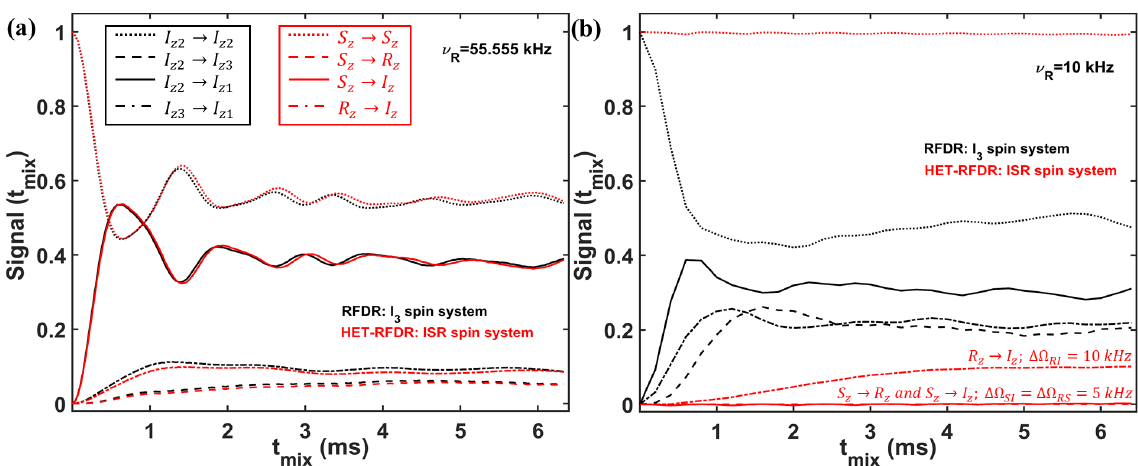
Figure 4. Comparison of the simulated RFDR and HET-RFDR signals. I 3 (three homonuclear spins, black lines) and ISR (three different spin types, red lines) for 55.555kHz (a) and 10kHz (b) MAS. An rf field of 83kHz is used (6µs of the widths of π pulses). The vertical axis shows the intensities of the starting and transferred signals between different operators of I 3 and ISR spin systems, respectively (the initial operator → the measured operator): I z → I z → S z – (dotted lines); I z → I z → R z – (dashed lines); I z → I z → I z – 2 2 and S z 2 3 and S z 2 1 and S z (solid lines); I z 3 → I z 1 and R z → I z – (dashed–dotted lines). For both spin systems, the offset ( (cid:127) ) and CSA (chemical shift anisotropy) values are [− 3 ; 2 ; 7 ] (kHz) and [ 5 . 2 ; 2 . 5 ; 3 ] . The dipolar coupling constants for the homonuclear spin system ( I 3 ) are ν 12 ,D = 7 . 333kHz, ν 13 ,D = 2kHz, ν 23 ,D = 0 . 333kHz. For the ISR spin system, all dipolar constants are 1.5 times larger: ν IS,D = 11kHz, ν IR,D = 3kHz, ν SR,D = 0 . 5kHz. The simulated measurements occur every two rotor periods. XY8 phase cycling was used. I z 1 → I z 1 , I z 3 → I z 3 , I z → I z and R z → R z are not